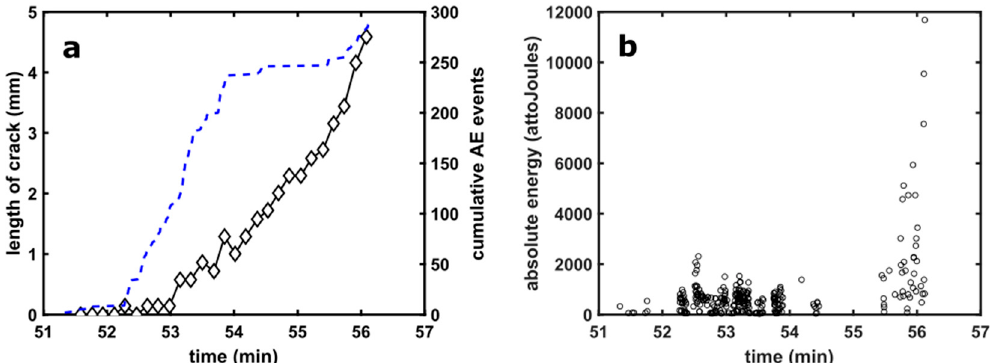
Figure 2. Results of TSA and AE testing on one specimen: ( a ) Length of crack as calculated using the optical flow algorithm (black diamonds) and cumulative AE events (blue dashed line). ( b ) Absolute energy of individual AE events.